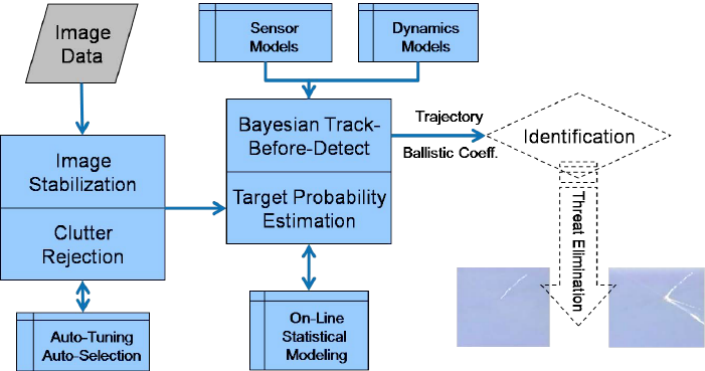
Fig. 2 Block diagram of the clutter simulation